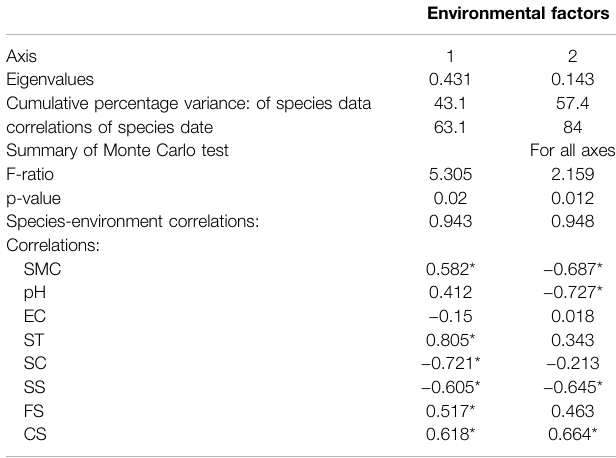
TABLE 3 | Correlation coef fi cients of the environmental factors, eigenvalue, cumulativepercentagevarianceofsoilmicroarthropodspeciesforthe fi rsttwo axes of RDA. Values are for Axis 1 and 2 plotted in the RDA diagram in Figure 4 . The highest canonical coef fi cients and correlations are highlighted by Asterisk (*) that indicates a signi fi cant level. * p < 0.05. SMC = soil moisture content, EC = electricalconductivity,SC=soilclay,SS=soilsilt,FS= fi nesand,CS=coarse sand, ST = soil temperature.